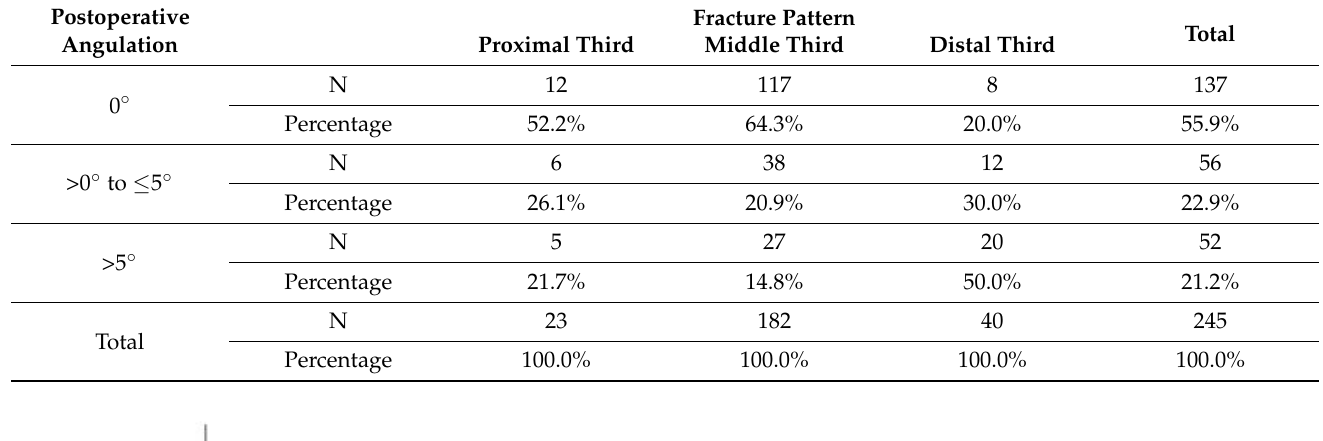
Table 1. Fracture pattern compared to postoperative angulations.